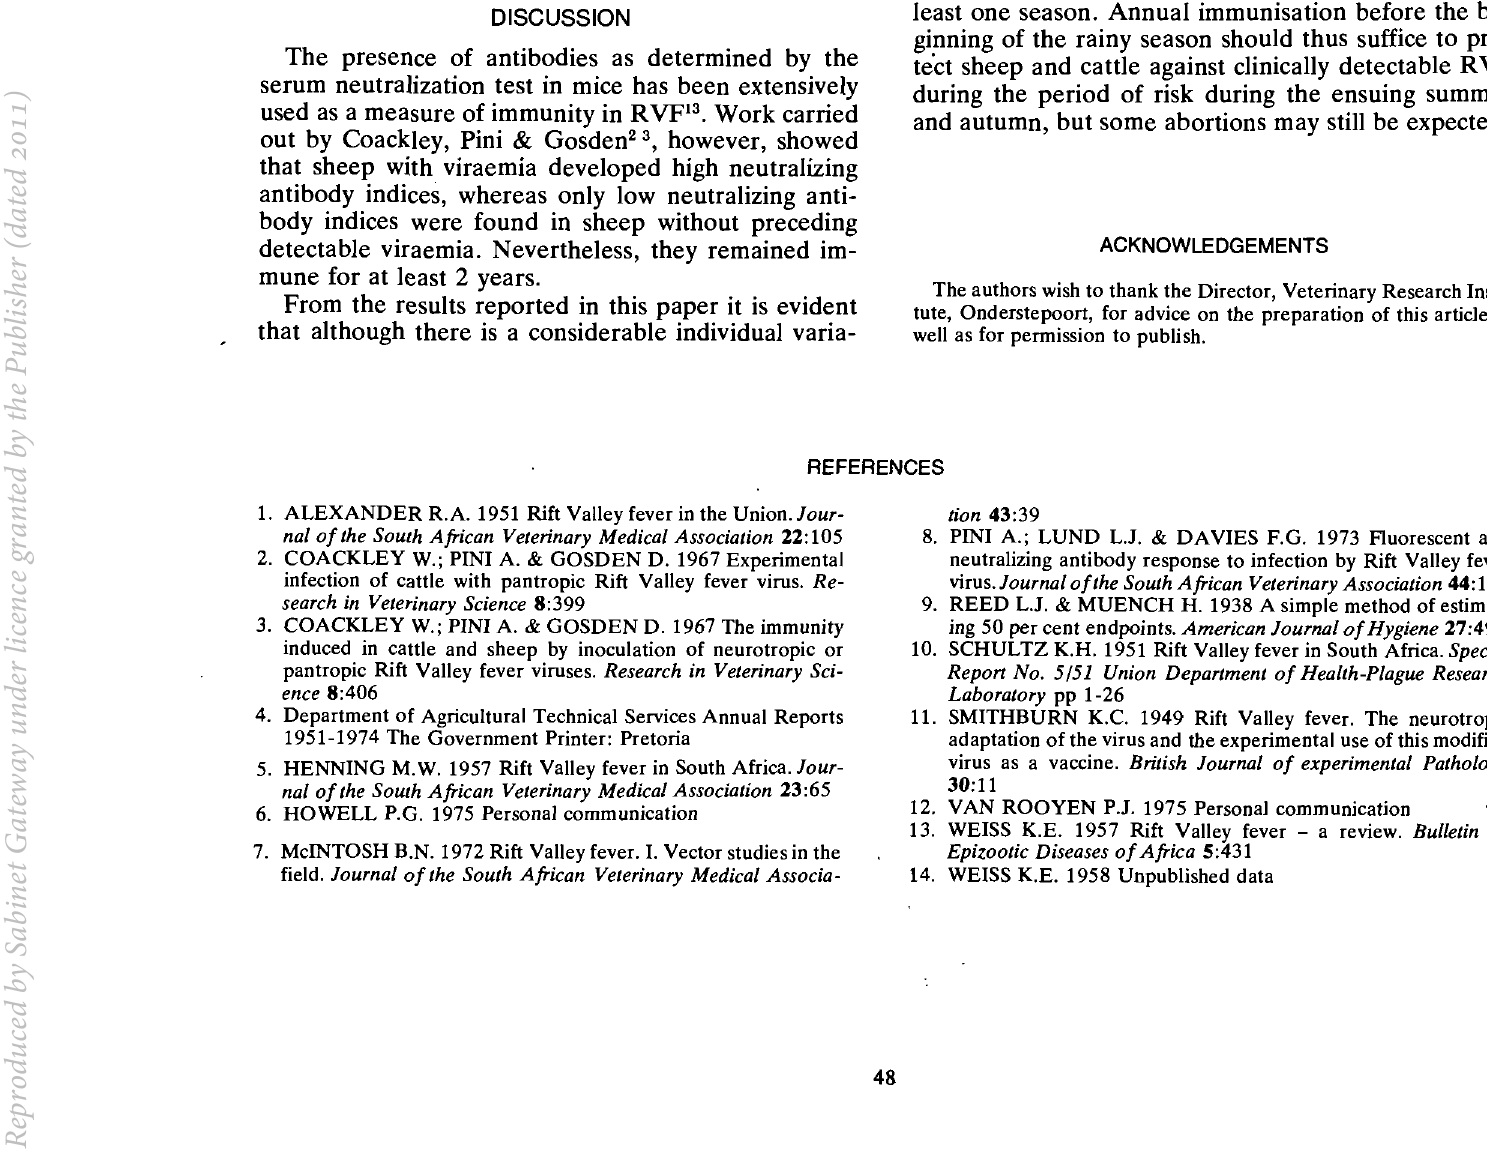
Fig. 4 Abortions and mortalities amongst ewes and lambs in inoculated and controlled ewes during a natural outbreak of Rift Valley fever.